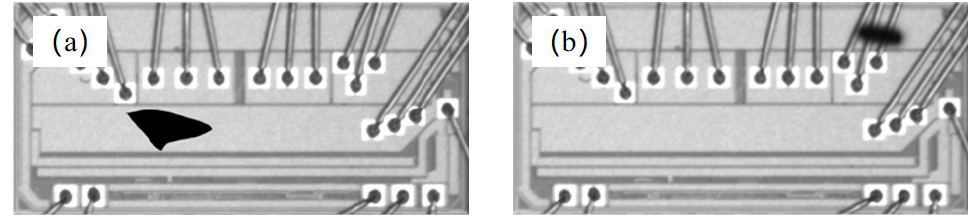
Figure 13. Comparison of foreign-body and fragmentation defects. ( a ) Foreign-body defect; ( b ) fragmentation defect.